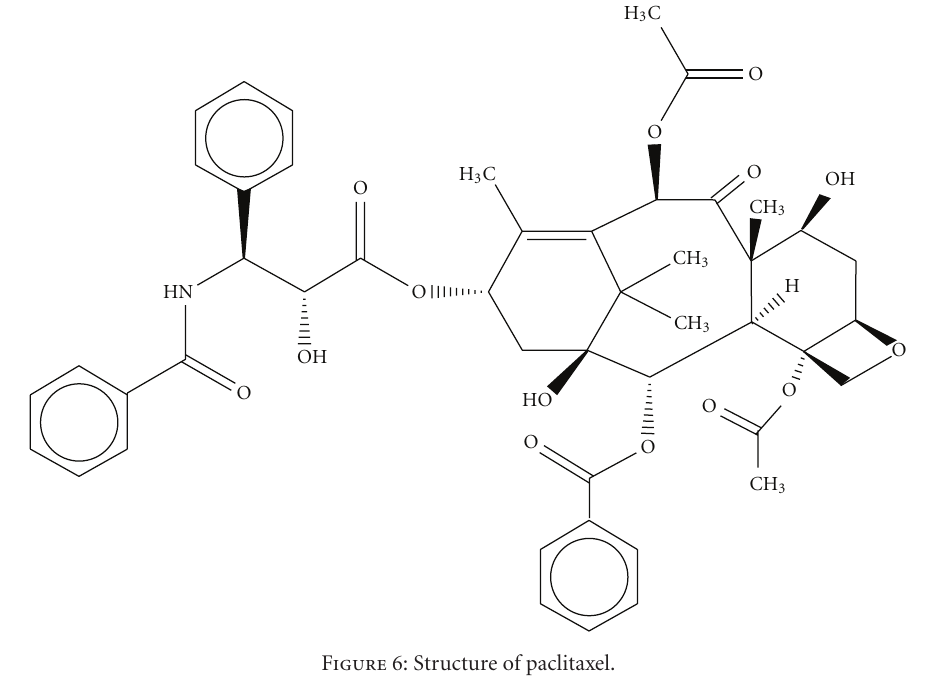
Figure 6: Structure of paclitaxel.